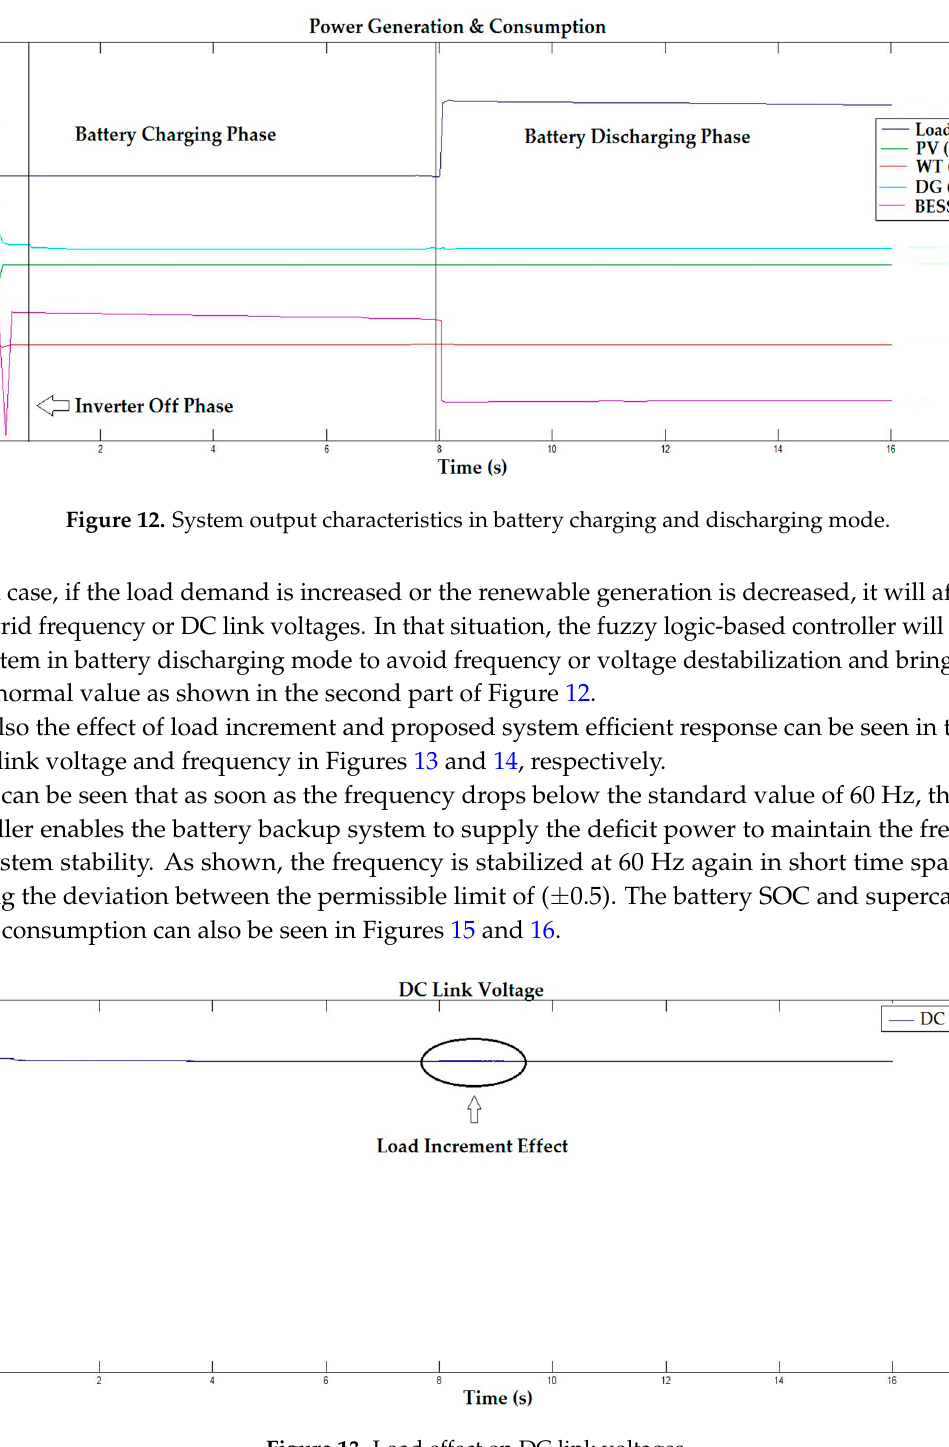
Figure 13 . Load effect on DC link voltages.